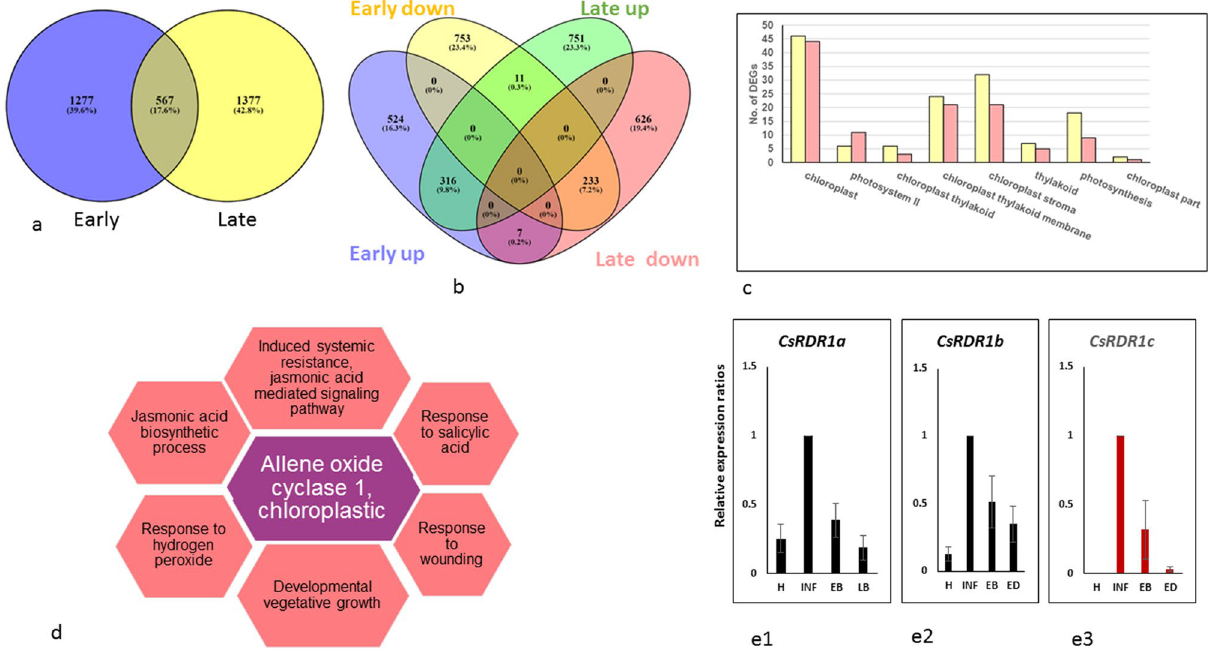
Figure 4. Differentially expressed genes (DEGs) and selected annotated cellular processes in bright yellow islands (BYIs) of CGMMV infected cucumber leaves at early and late post-recovery stages compared to the corresponding dark green surrounding tissues. ( a ) Venn diagram showing the overlap between DEGs in BYIs of CGMMV infected cucumber leaves at the early and late post-recovery stages compared to the corresponding dark green surrounding tissues. ( b ) Venn diagram showing both unique and overlapping distribution of up-regulated and down-regulated DEGs found in the BYIs at the early and late post-recovery stages compared to the corresponding dark green surrounding tissues. Early, ’early post-recovery stage’ BYIs; Late, ’late post- recovery stage’ BYIs; up, upregulated DEGs; down, downregulated DEGs. ( c ) Distribution of 219 DEGs out of the total 233 downregulated DEGs, shared by early and late post-recovery stage BYIs, among the various annotated cellular processes associated with the photosynthesis pathway. Yellow colored columns, no. of DEGs downregulated in the ’early post-recovery stage’ BYIs; pink colored columns, no. of DEGs downregulated in the ’late post-recovery stage’ BYIs. ( d ) Depiction of selected cellular pathways annotated for allene oxide cyclase one, one of seven DEGs upregulated in ‘early post-recovery stage’ BYIs and downregulated in ‘late post-recovery stage’ BYIs. ( e1–3 ) RT-qPCR analyses showing relative gene expression ratios of CsRDR1a , CsRDR1b and CsRDR1c genes in early and late post-recovery stage BYIs and the associated dark green surrounding tissues. H, healthy control; INF, a CGMMV systemically infected cucumber leaf; EB, ’early post-recovery stage’ BYIs;